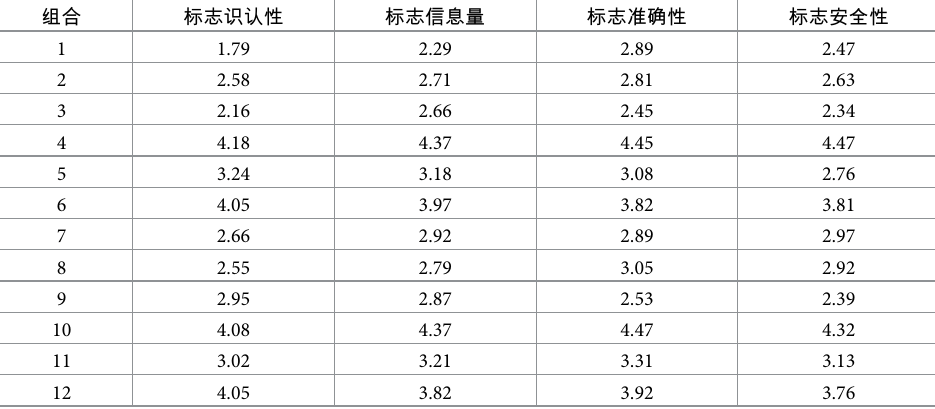
Table 11. Comprehensive evaluation score of exit advance guide signs in different information